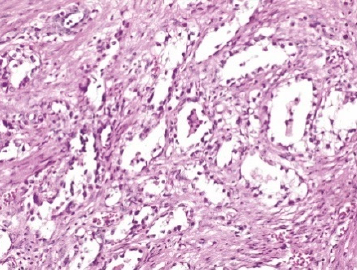
Figure 2. H&E stain—Vaginal wall with non-specific chronic inflammation, at the level of the subepithelial stroma we find micro focaries of mesonephric remains within the histological limits of benignity.